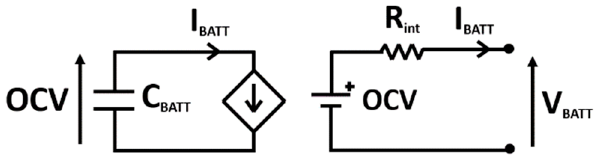
Figure 2. Electrical model of a lithium-ion battery cell.